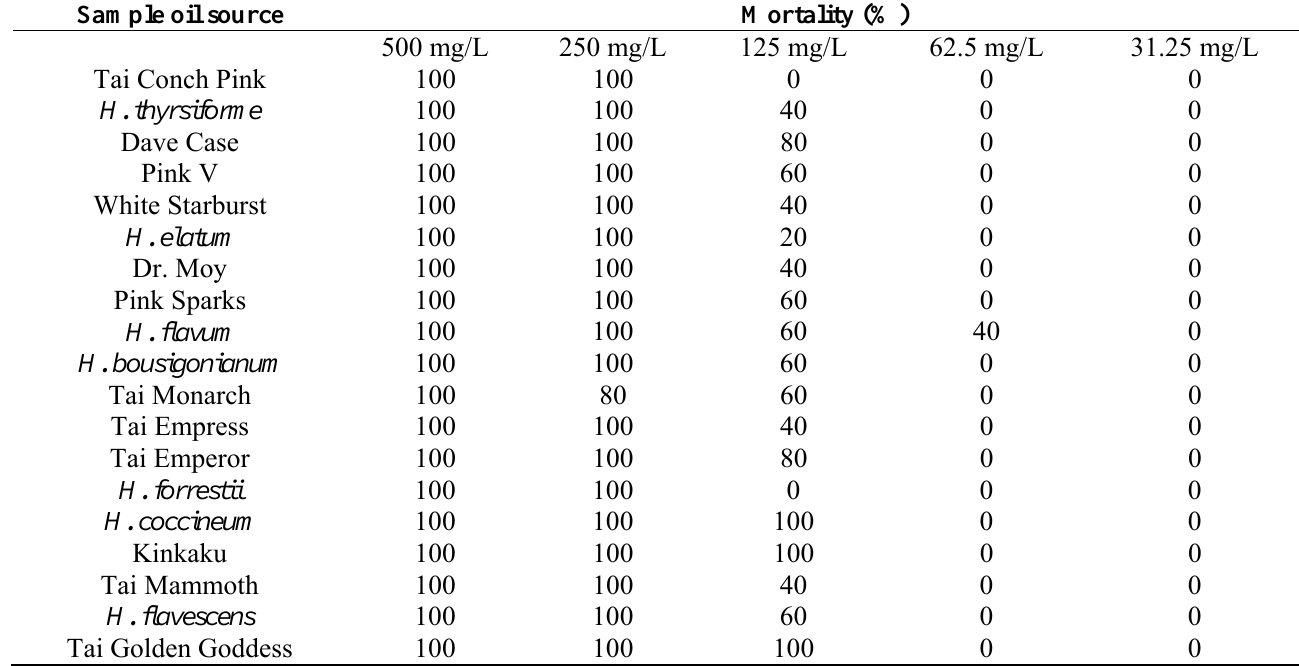
Table 4. Larvicidal activities of Hedycium essential oils against first instar larvae of Aedes aegypti. Sample oil